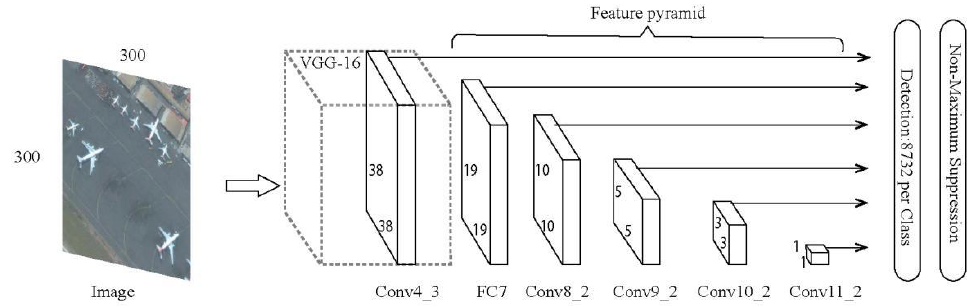
Figure 2. Architecture of the Single Shot MultiBox Detector with input size 300 × 300.